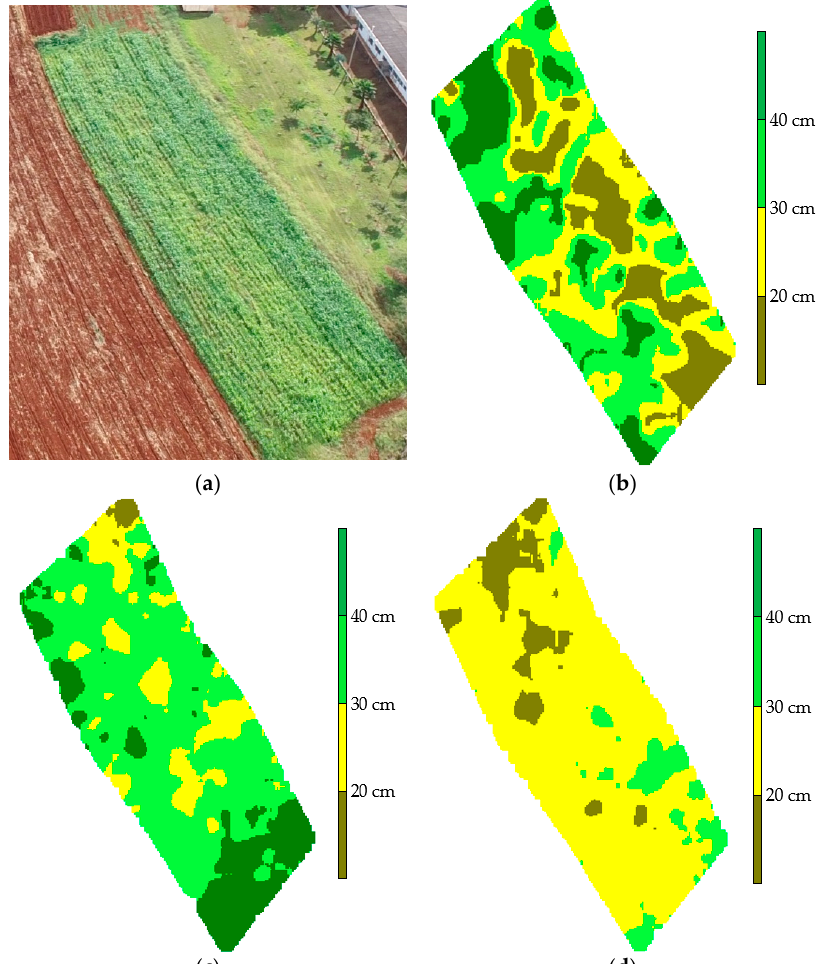
Figure 16. Crop growth maps derived from three acquisition intervals: ( a ) optical reference image from corn crop ( b ) from 2 July to 17 July 2019; ( c ) from 2 July to 22 August 2019; and ( d ) from 17 July to 22 August 2019.